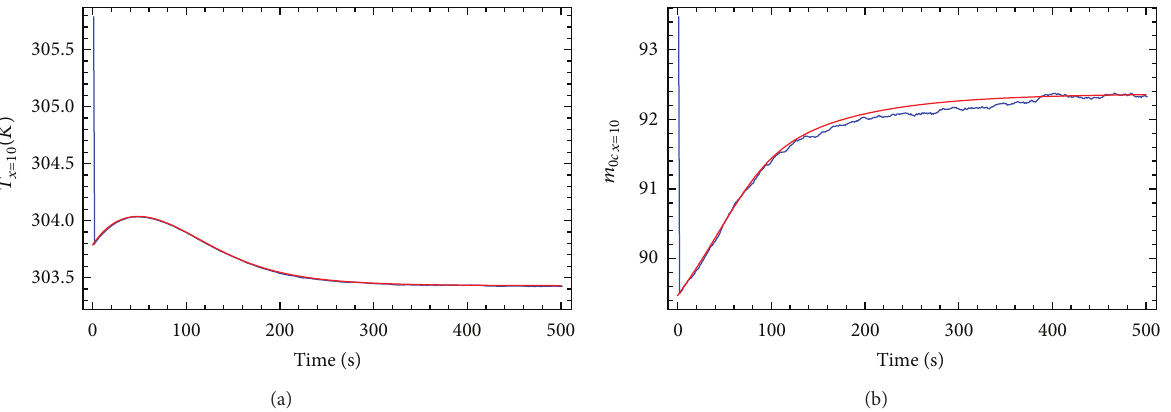
Figure 12: States (red) and estimates (blue) at the first drying zone’s mid point.